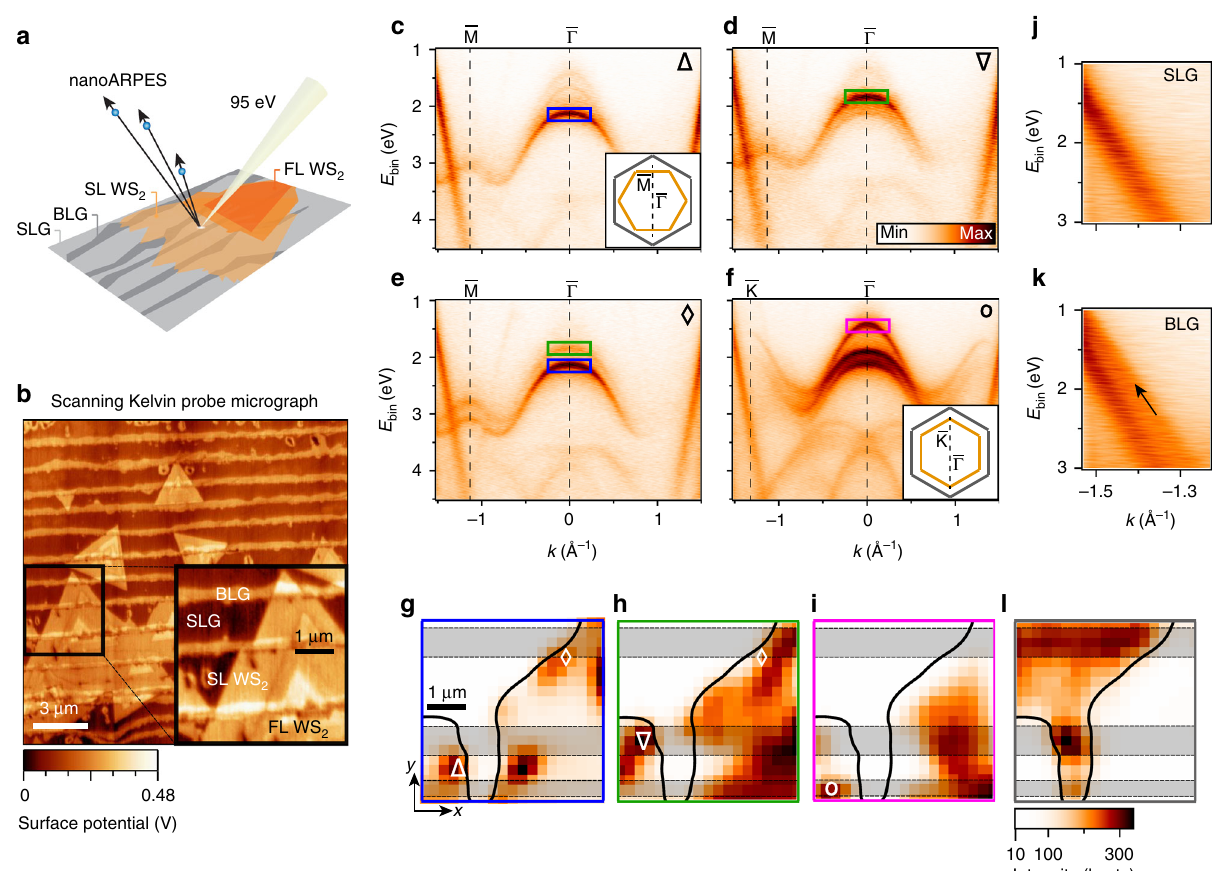
Fig. 1 Nanoscale spatial mapping of WS 2 electronic dispersion on a variable number of graphene layers. a Sketch of the nanoARPES experiment. b Scanning Kelvin probe micrograph showing the variation in surface potential over a typical area of the sample. The inset highlights an area containing SLG and BLG, as well as SL and FL WS 2 , similar to the samples measured with nanoARPES. c – f Representative ARPES spectra binned over 500 × 500 nm 2 areas in the real space maps of the photoemission intensity in panels ( g – i ). The symbols Δ , ∇ , ♢ , ο on the maps in ( g – i ) indicate where a given ( E , k )-dispersion in the correspondingly labeled panel in ( c – f ) was extracted. The Brillouin zones in the insets of ( c , f ) (gray for graphene, orange for WS 2 ) give the orientation of the WS 2 island in the acquisition area with respect to the underlying graphene for panels ( c – e ) and ( f ), respectively, along with the cut direction for the measurement (black dashed line). High symmetry points refer to the WS 2 Brillouin zone. All data have been acquired along the (cid:1) K – (cid:1) Γ – (cid:1) K ′ high symmetry direction of the single-domain graphene Brillouin zone as explained in Supplementary Note 1 and Fig. S1. The intensity maps in ( g – i ) are composed from the photoemission intensity in the ( E , k )-regions marked with boxes of the same color in ( c – f ). An outline of the WS 2 island edges has been drawn and the underlying BLG stripes are highlighted by gray-shaded boxes. j , k Detailed dispersion around the graphene branches from j SLG and k BLG stripes. l Intensity map obtained from the BLG branch marked by an arrow in ( k ). The color scale bar in ( l ) also applies to ( g – i peaks separated by 0.3 eV. By plotting the spatial distribution of the photoemission intensity at each of the peak energies marked by green and blue bars, we obtain the maps shown in Fig. 2b, c corresponding to the VB analysis in Fig. 1. The peak at a lower binding energy (see green bar in panel (a)) appears to coincide with BLG areas as seen in panel (b) while the peak at a higher binding energy (see blue bar in panel (a)) is concentrated on the SLG areas as seen in panel (c). The trend is thus consistent with the spatial VB maps in Fig. 1g, h.